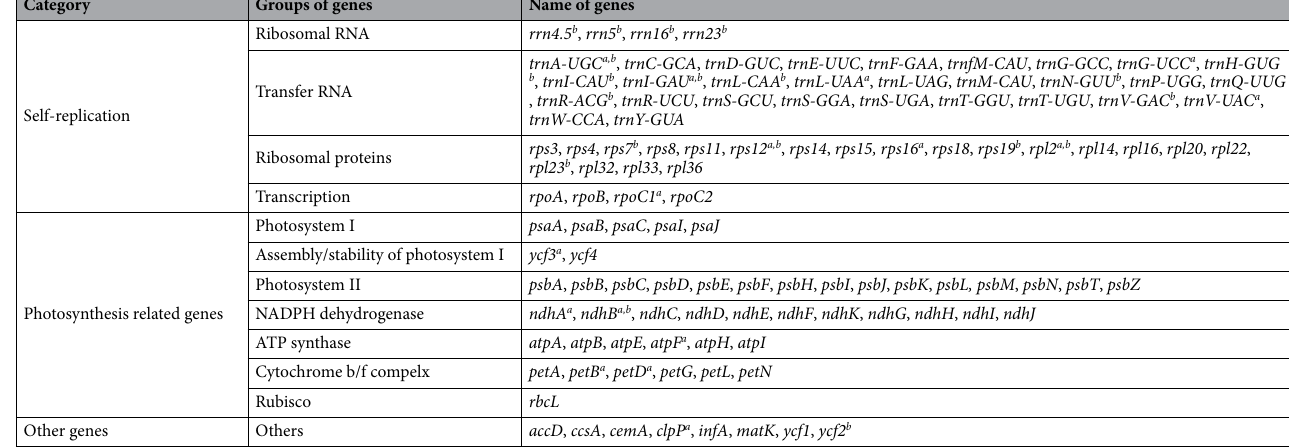
Table 1. Genes contained in Allium mongolicum chloroplast genome. a Intron-containing genes. b Genes located in the IR